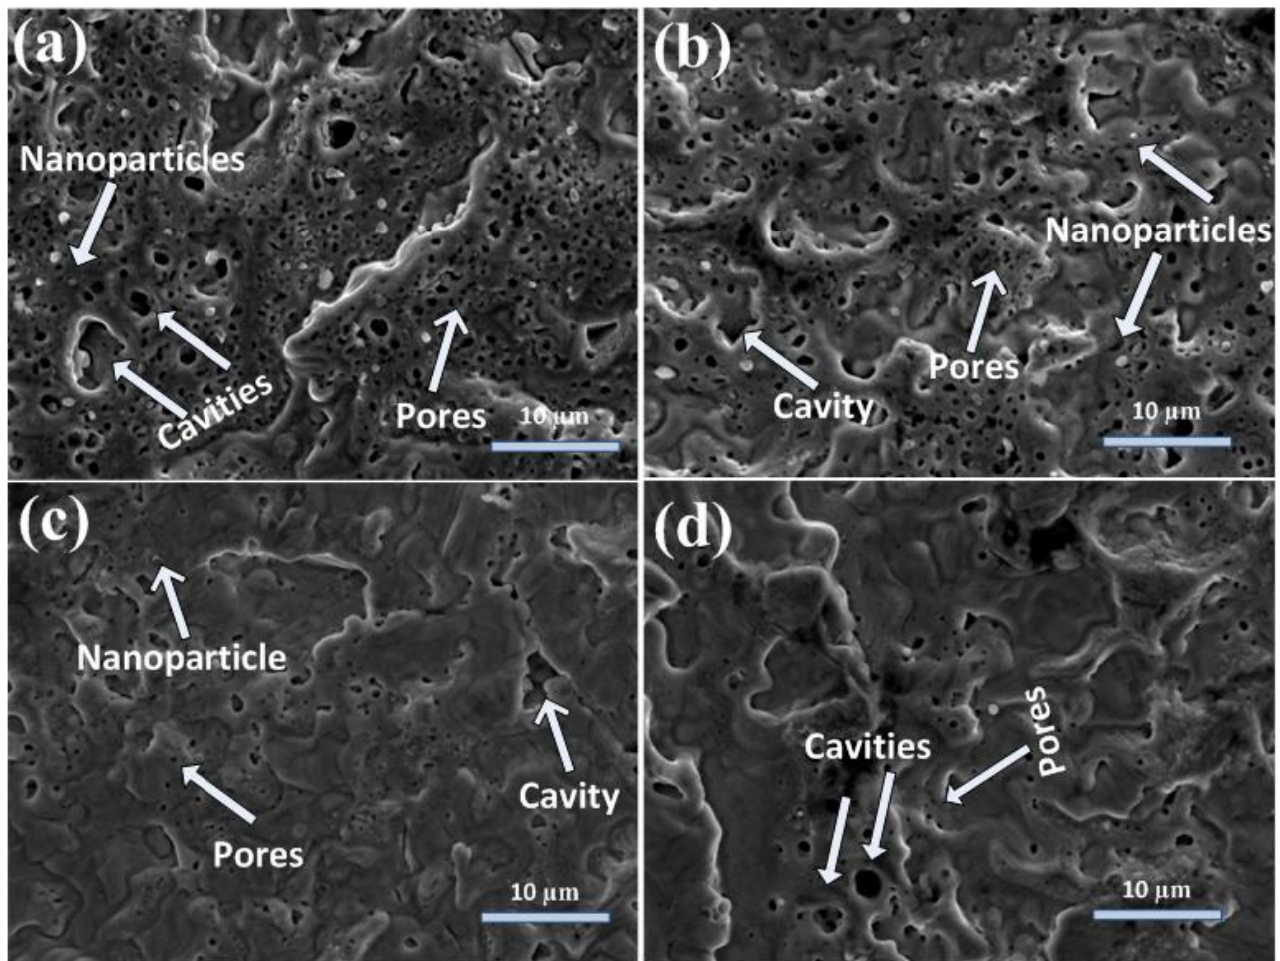
Figure 2. SEM images of peripheral ablated areas of Cd targets exposed to ( a ) 500, ( b ) 1000, ( c ) 1500, and ( d ) 2000 laser pulses at a constant fluence value of 3.6 Jcm − 2 in DI